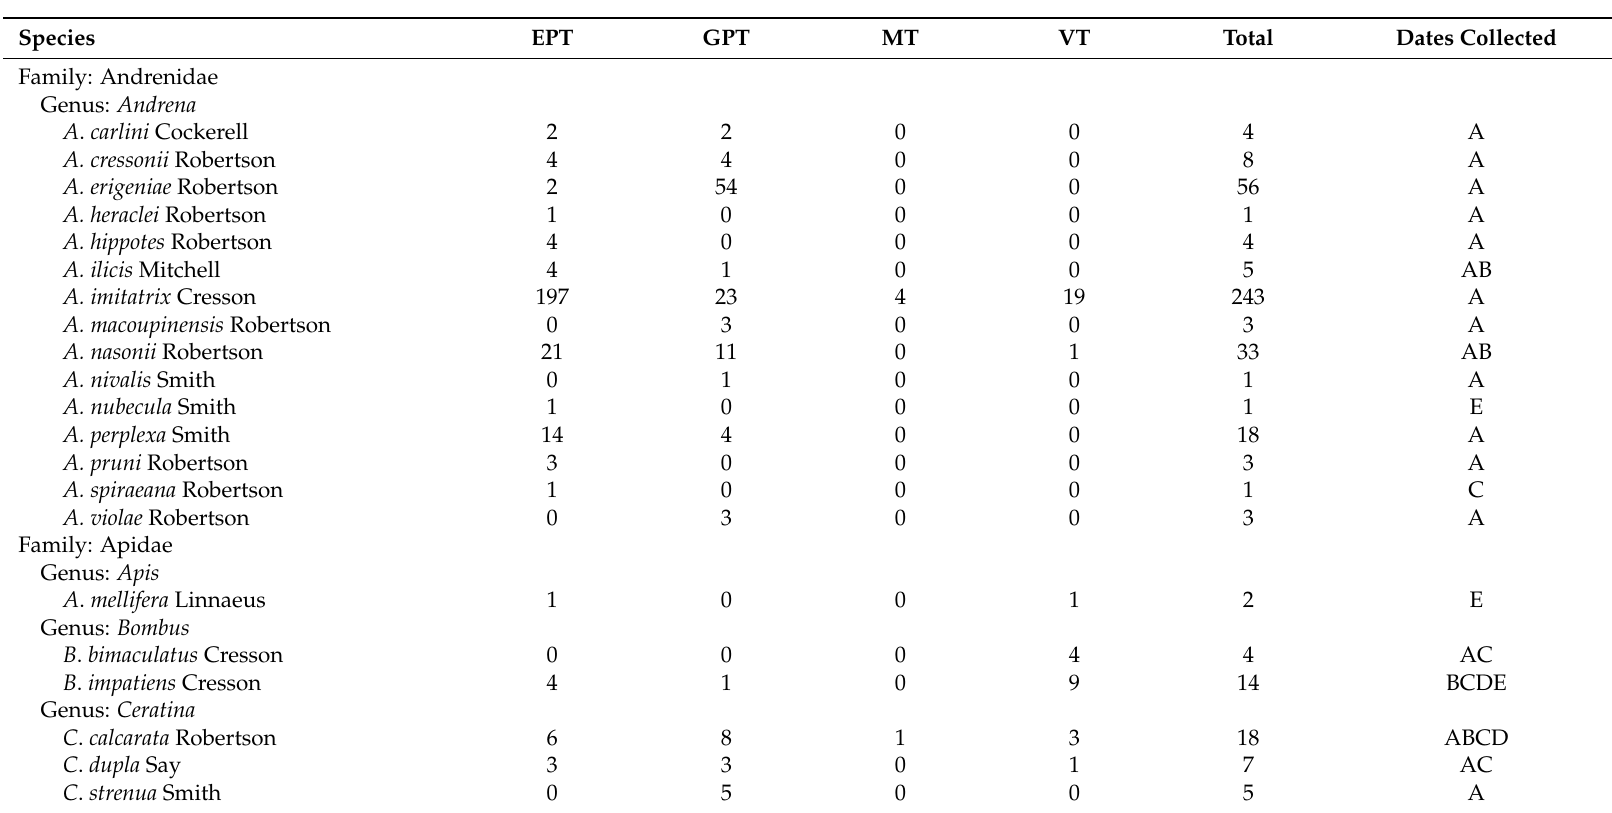
Table 1. Totals ( n ) and mean numbers of bees (with standard deviations), Simpson’s diversity indices (D), and totals ( S obs ) and mean bee species richness (with standard deviations) collected using four sampling methods, with abundance coverage estimators (ACE) and Chao1 estimates ( S est , with standard deviations) of minimum asymptotic species richness, n required to achieve a specified percentage of S est , and probabilities of an additional individual being a previously undetected species ( q 0 ) in oak-hickory forest in Hancock County, IL, USA, April–September 2011. Means followed by different letters are significantly different ( p < 0.05; Holm-Sidak multiple comparison procedure); Simpson’s diversity values followed by different letters are significantly different ( t- tests; p -values for multiple comparisons adjusted using Holm’s step-down procedure). ACE, S est , q 0 and n required to achieve a specified percentage of S est for malaise traps should be interpreted with caution because of low sample size. EPT = elevated pan trap, GPT = ground-level pan trap, MT = malaise trap, VT = vane trap, A = 12 April, B = 28–29